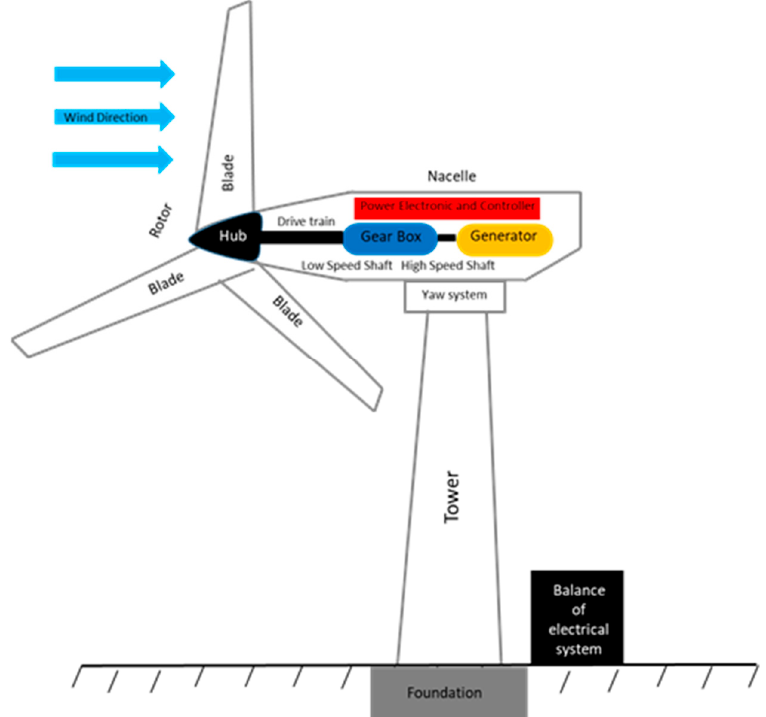
Figure 1. Components of a wind turbine.